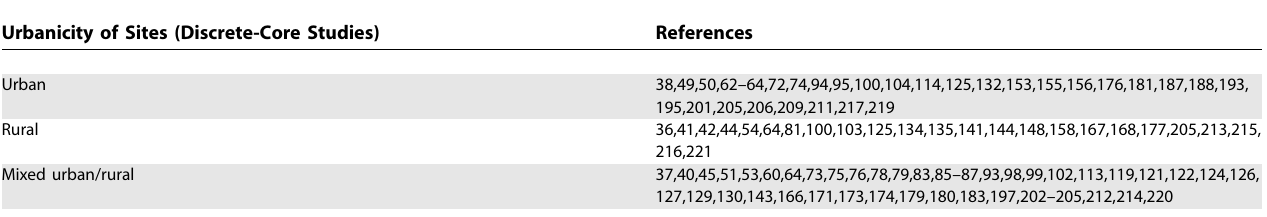
Table 4. References by Urbanicity of Sites Urbanicity of Sites (Discrete-Core